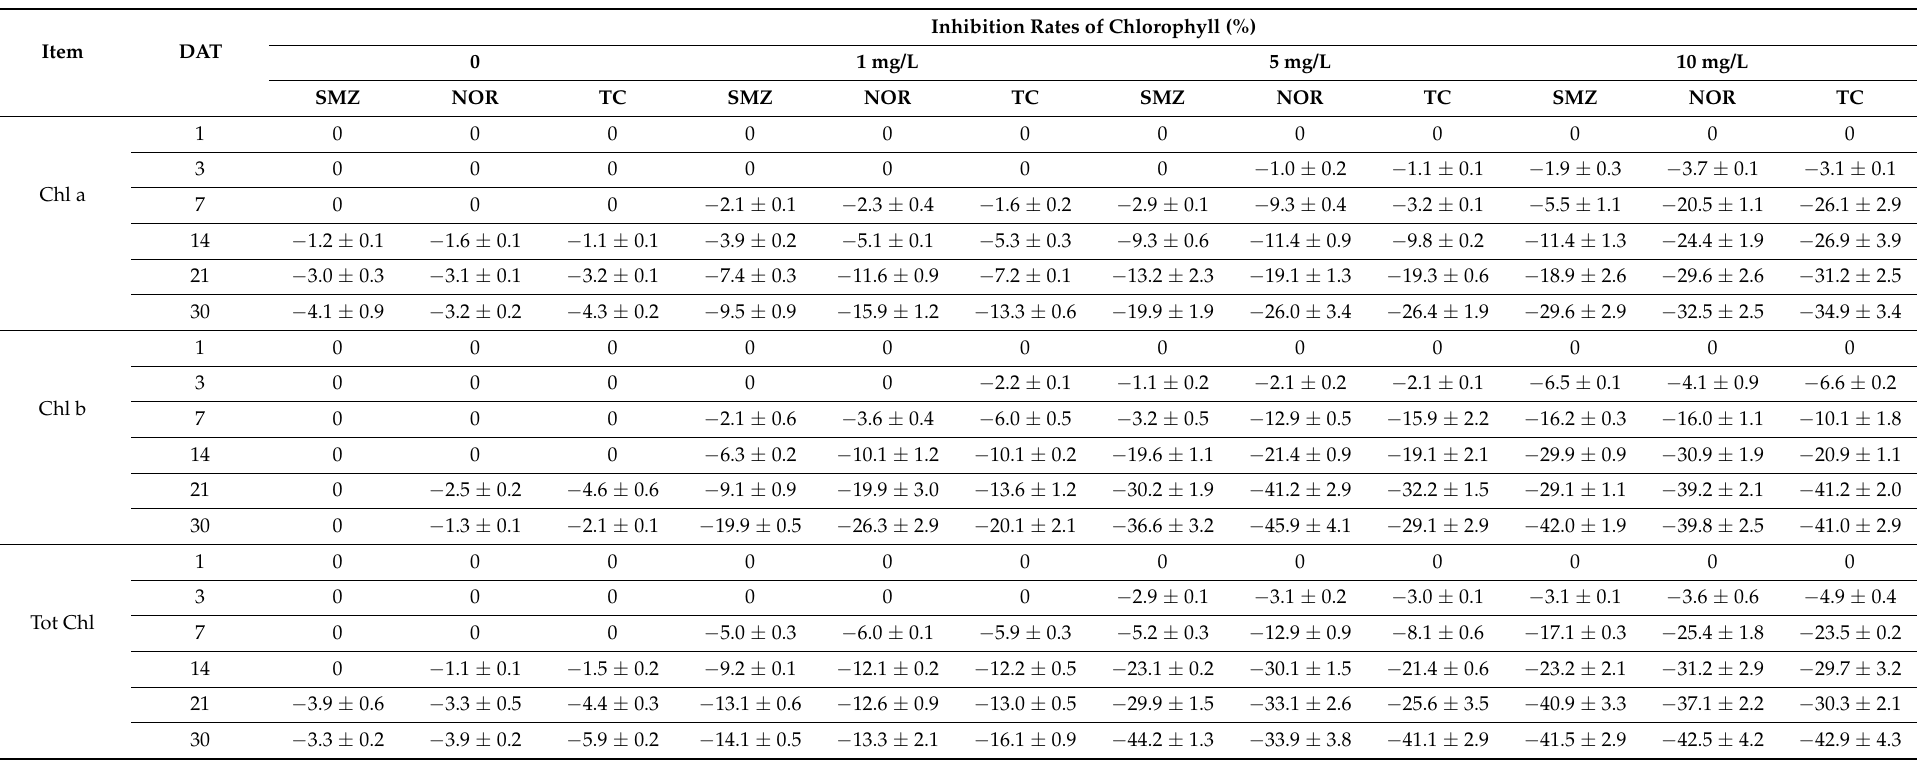
Table 4. Effects of antibiotics on concentrations of Chl a, Chl b, and total Chl in leaf tissues of parrot feather ( Myriophyllum verticillatum) . Values are the mean ± S.D. of three parallel individuals in each container, with three measurements from each